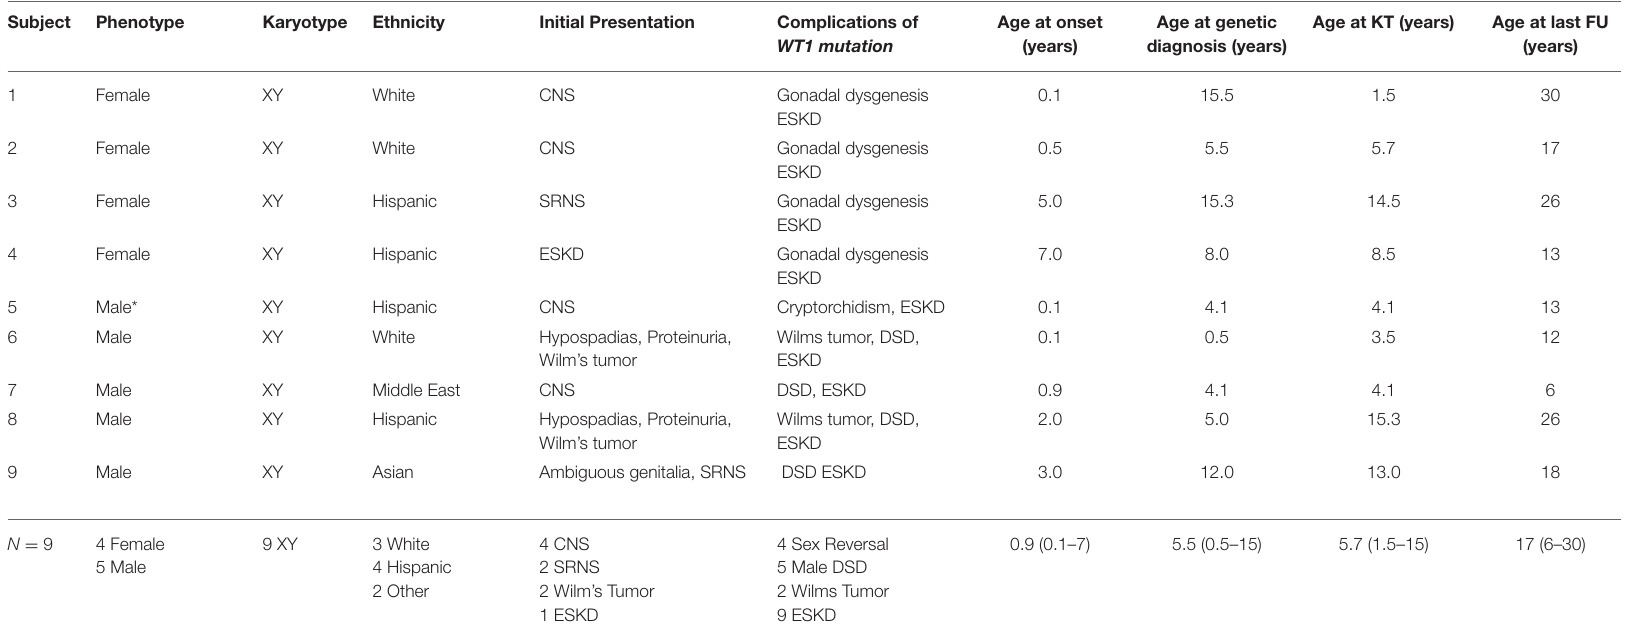
TABLE 1 | Case series at university of